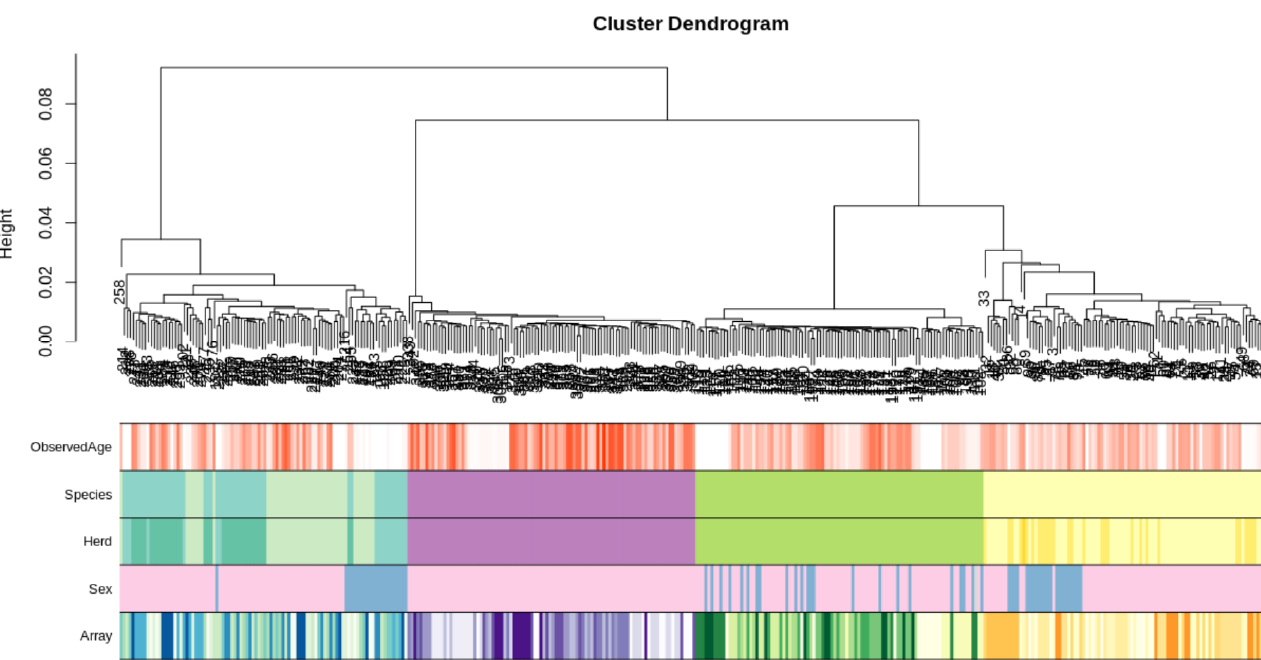
Figure 1. Hierarchical clustering of the complete methylation dataset for each sample (excluding sheep samples that failed QC). Species are coloured yellow for sheep-related covariates, green for goat-related covariates, purple for cattle related covariates and turquoise/blue for deer-related covariates (note: the two shades of turquoise in the species panel denote animals that are predominantly Red (greenish) and Wapiti (blueish) breeds, respectively). Sex is coloured pink for females, blue for males and grey for hermaphrodite samples. The data form four distinct clusters based on species; there is some sub-clustering based on sex; there is no obvious sub-clustering attributed to the array the sample was run on.